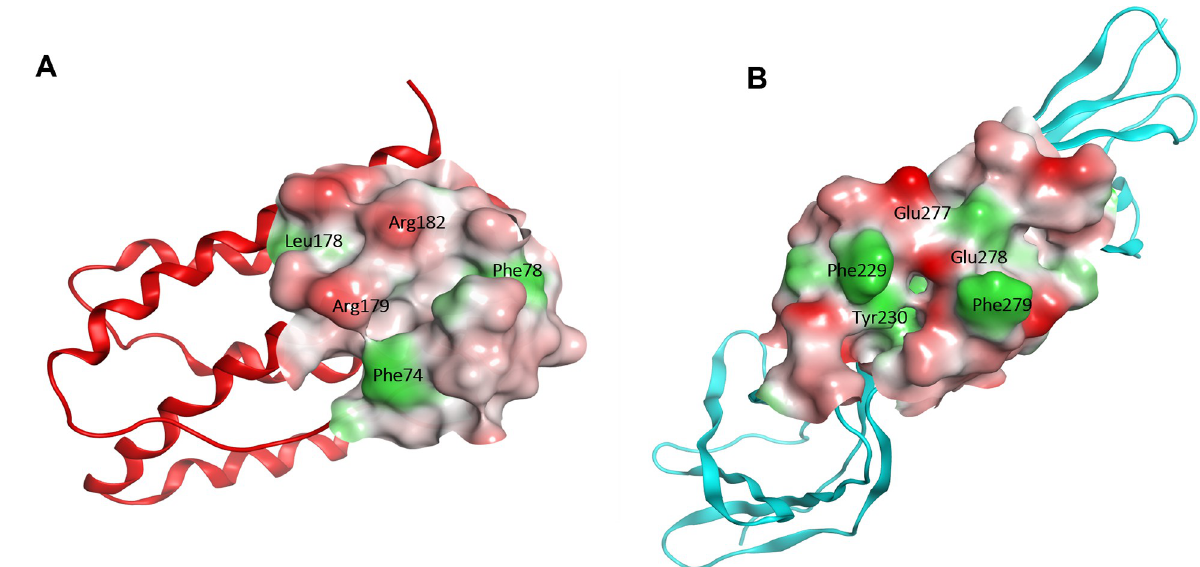
Fig 3. The molecular docking models D- IL-6 (A) and D-IL-6R α (B) were generated by the hot-spot residues at the binding site.